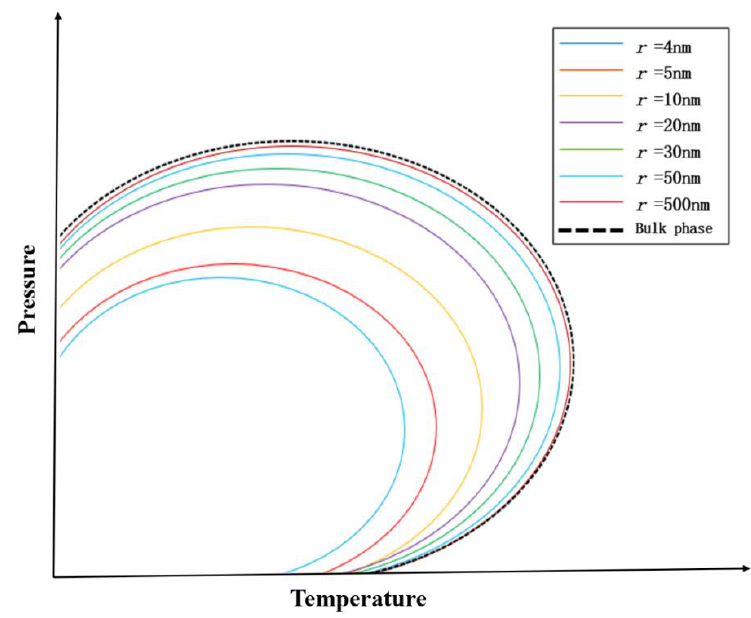
Figure 8. Schematic diagram of phase shift at different diameters (modified from [84]).